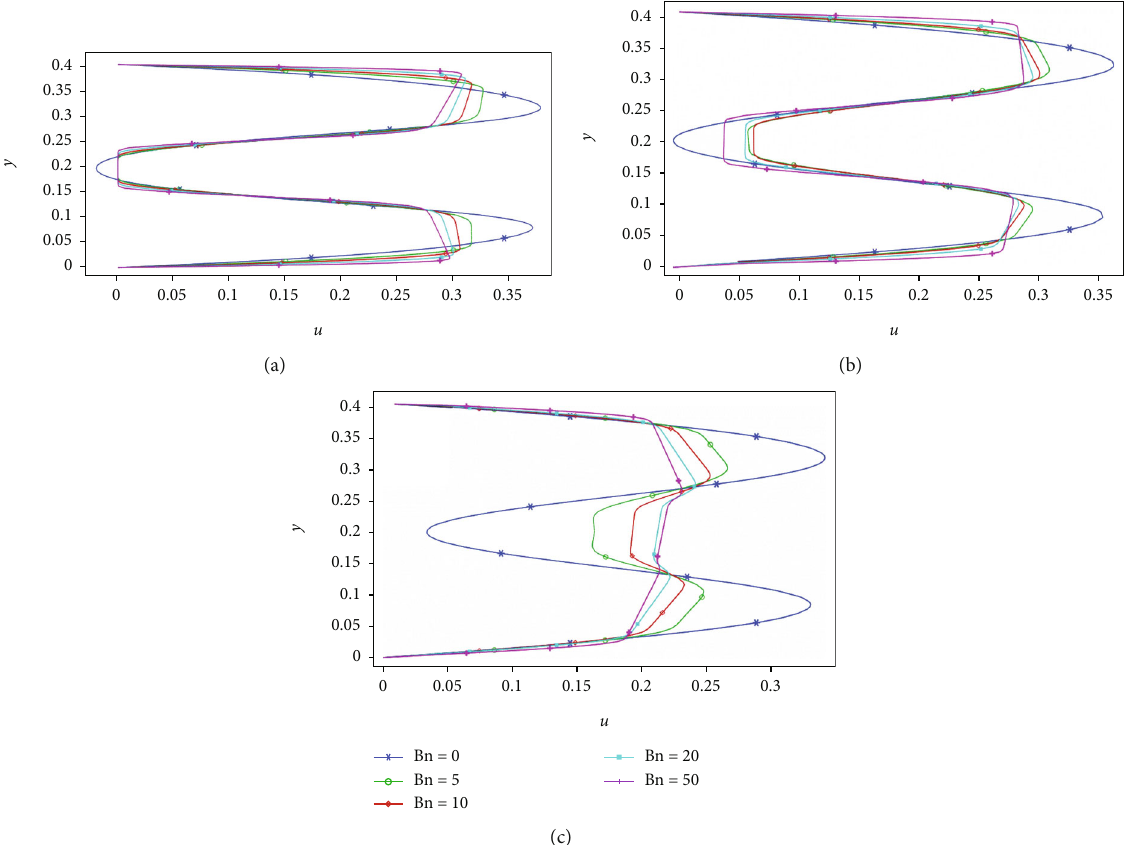
Figure 12: Impact on u velocity for di ff erent Bn . (a) Gp = 0 : 1 m , x = 0 : 3 m . (b) Gp = 0 : 2 m , x = 0 : 35 m . (c) Gp = 0 : 3 m , x = 0 : 4 m